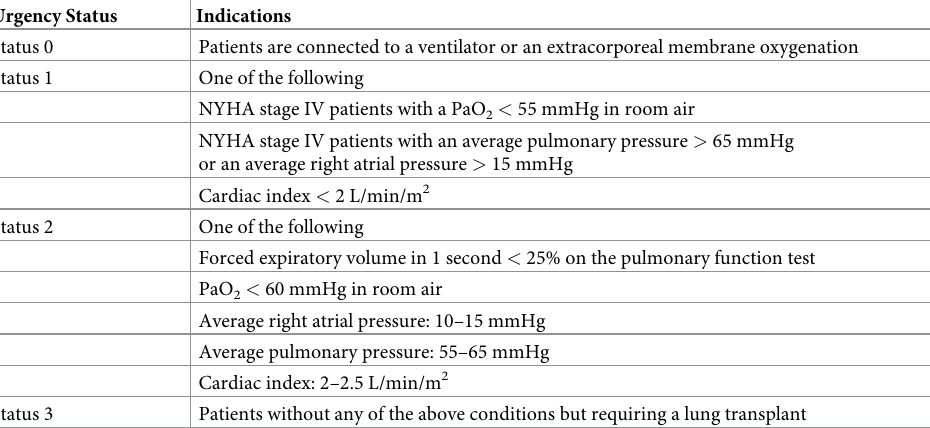
Table 1. Definition of urgency status in